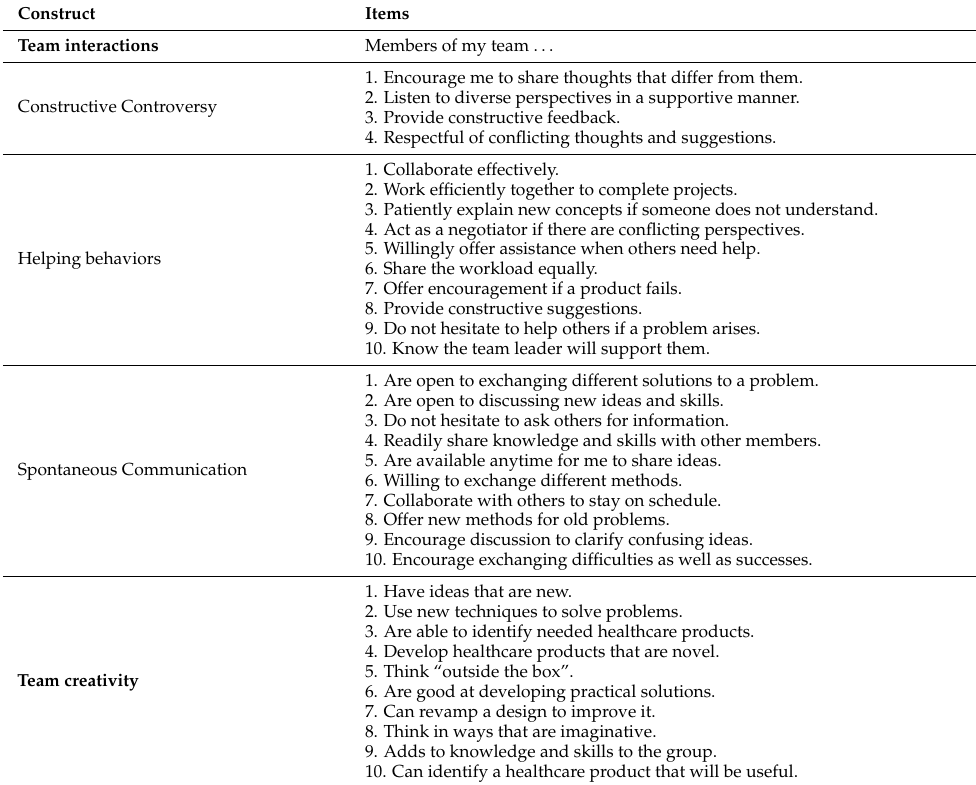
Table 1. Items for the Team Interactions and Team Creativity scale for nursing students in Taiwan